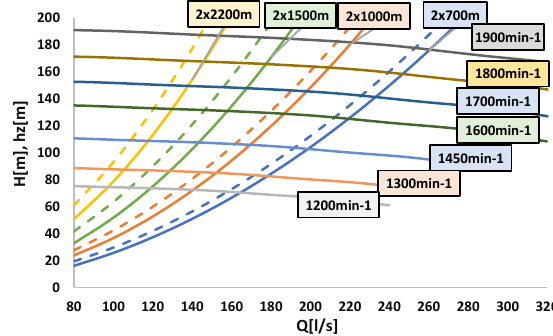
Table 2. Comparison of pressure p 6 , loss head for MATLAB and field deployment methodology .